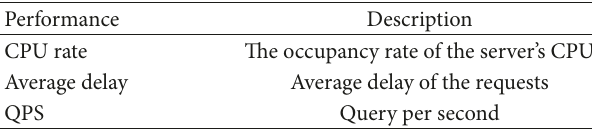
Figure 6: Proportion of each ID on data set B.